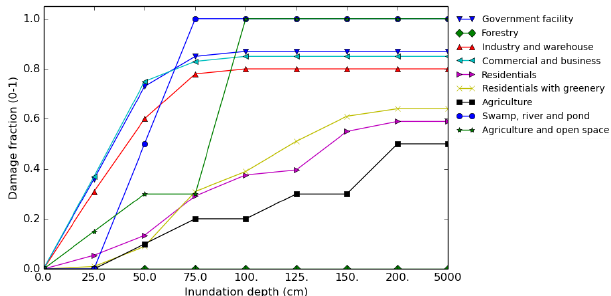
Figure 4. Depth–damage functions used in this study for each land use class.